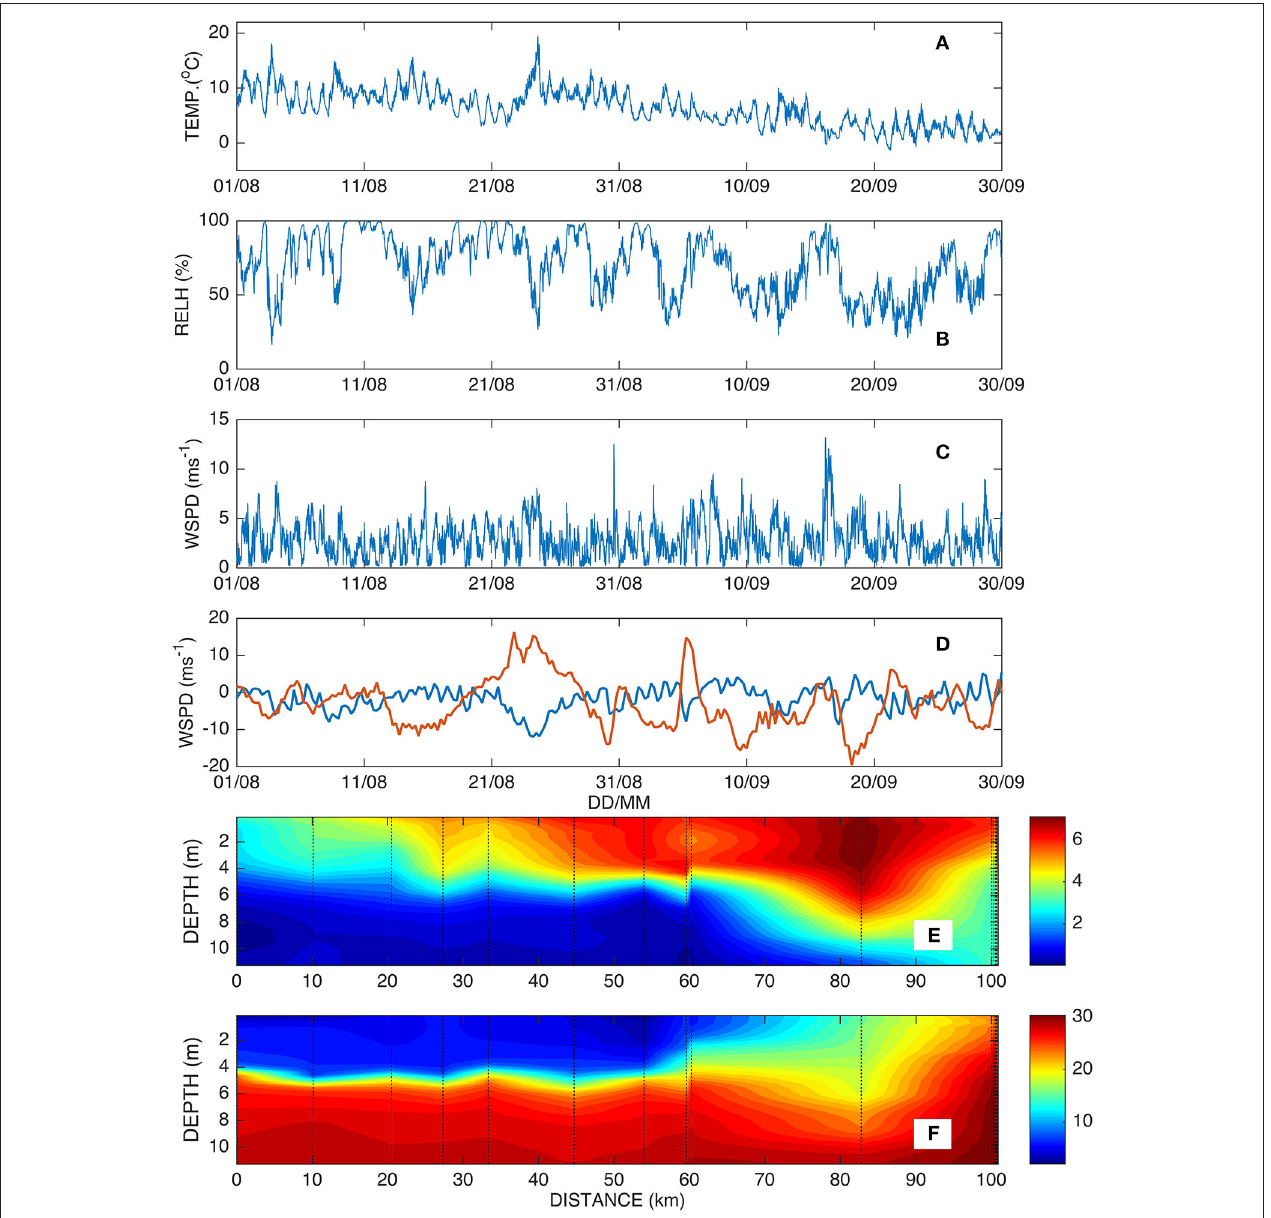
FIGURE 3 | Time series of (A) air temperature, (B) relative humidity, and (C) wind speed during August and September 2016 as observed by the Asiaq Greenland Survey meteorological station. (D) Zonal (blue) and meridional (red) wind speeds from the NCEP/NCAR reanalysis grid point nearest GF. (E) Along-fjord transect of temperature and (F)